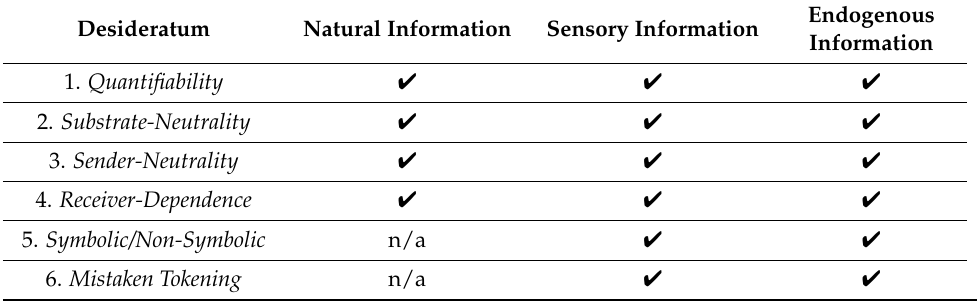
Table 1. A list of identified desiderata and their applicability to three types of information. Desideratum Natural Information Sensory Information